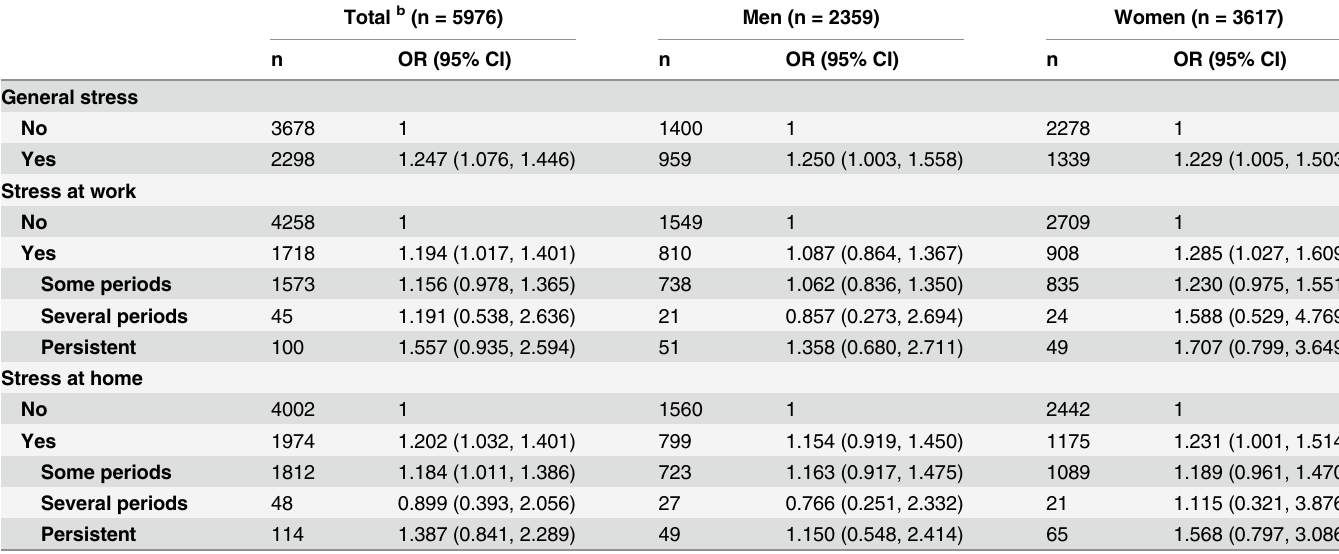
Table 3. Adjusted odds ratios (ORs) a for hypertension by the different types of stress.